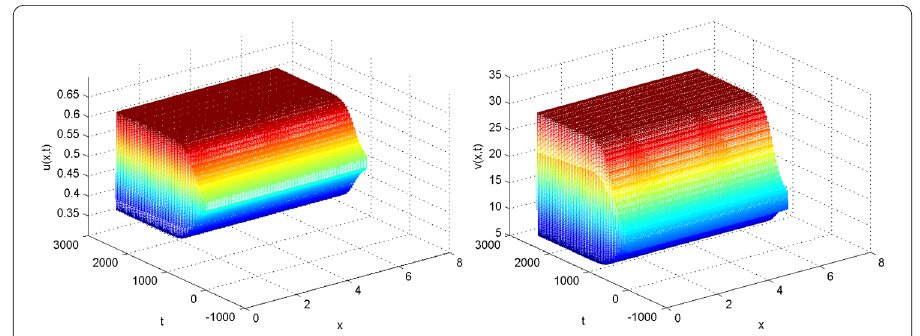
Figure 6 For system (1.3), τ = 9.2 and the initial condition is (0.5,12). Left component: u ( x , t ) (Periodic solution). Right component: v ( x , t ) (Periodic